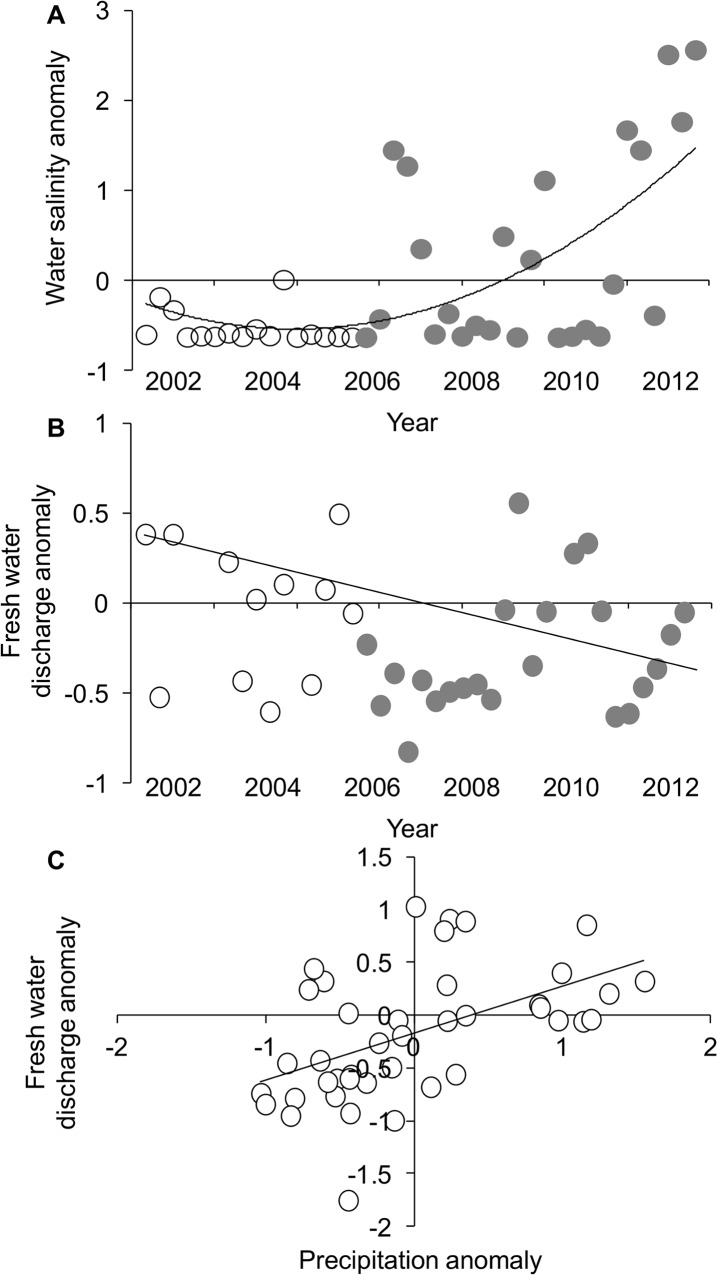
Environmental variation of the Matanzas River estuary.(A) From 2002 to 2011, the seasonal anomaly of water salinity. (B) From 2002 to 2012, the seasonal anomaly of freshwater discharge. (C) The relationship between the seasonal anomaly of freshwater discharge and the seasonal anomaly of local precipitation. In (A-B), open symbols denote data points before 2006, and gray symbols denote data after 2006. All data were normalized according to the overall seasonal mean and seasonal standard deviation ([overall mean—seasonal mean] / overall standard deviation).